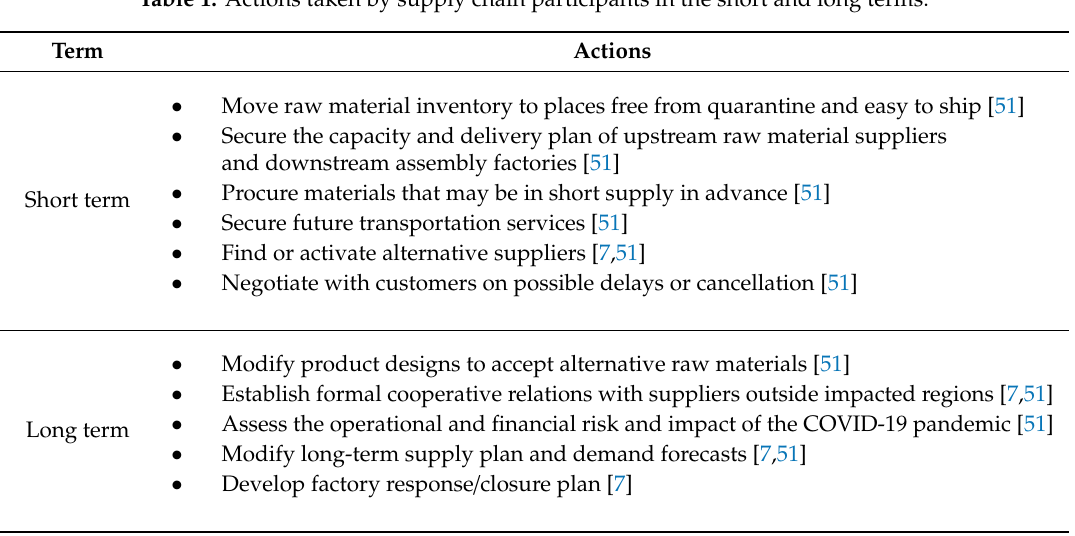
Table 1. Actions taken by supply chain participants in the short and long terms.